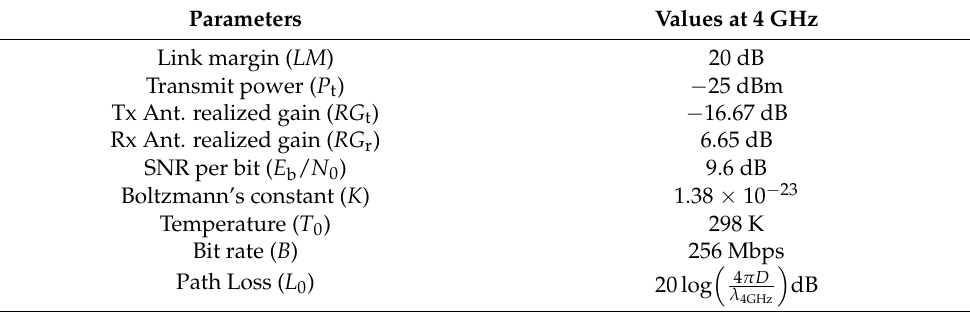
Table 4. Parameters for link budget